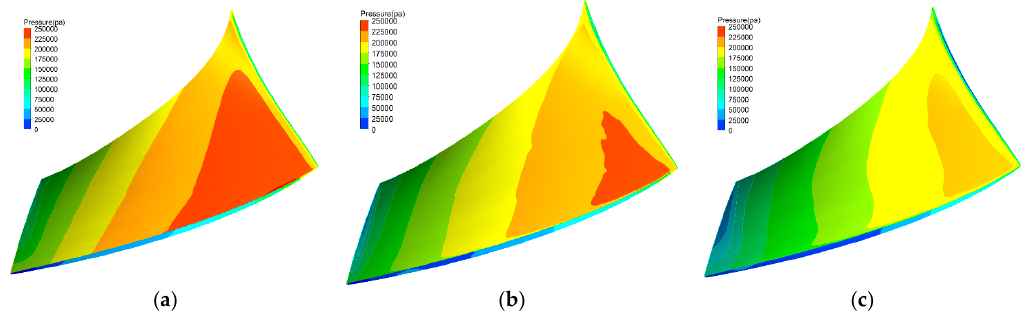
Figure 13. Pressure distribution on blade pressure side for different tip clearances: ( a ) 0 mm; ( b ) 1 mm and ( c ) 2 mm.